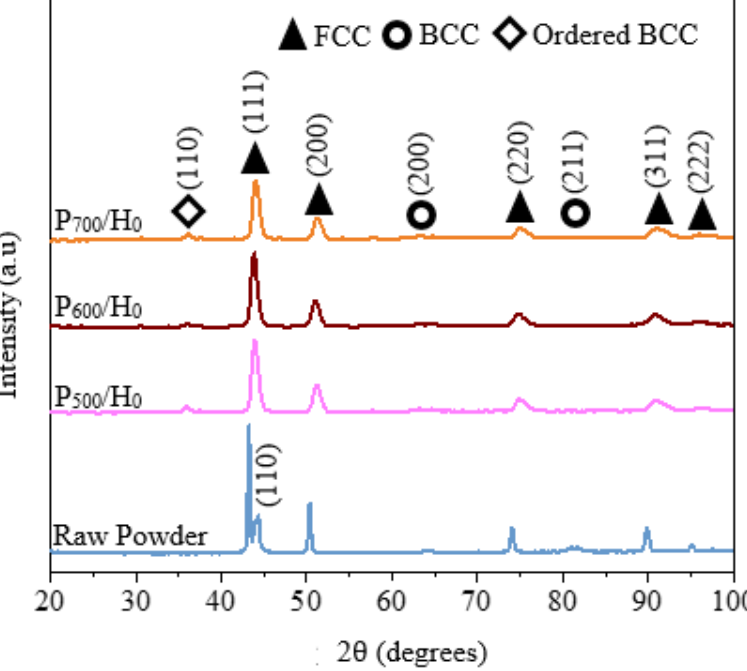
Figure 2. XRD spectrum for of the 10–60 µ m powder and as-sprayed coatings at varying spraying powers from P 500 /H 0 to P 700 /H 0 .